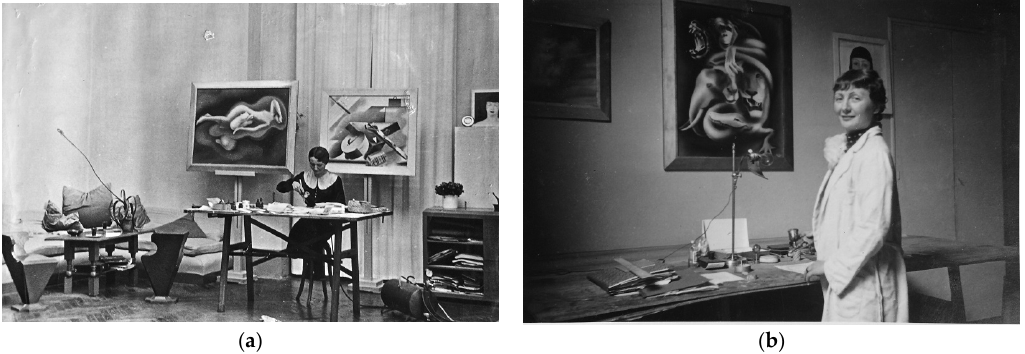
Figure 1. Fides Testi ( a ) in her study while ( b ) working with the airbrush, mid-1930s. © Private Pensabene Archive, Rome. Used by permission.